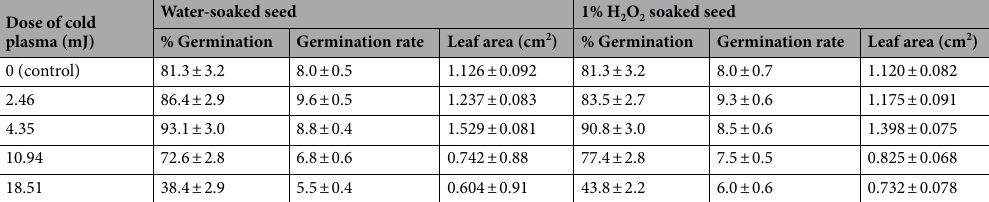
Table 2. Percentage germination and average leaf area of Moringa oleifera seeds treated with different doses of atmospheric pressure cold plasma for 10 min.